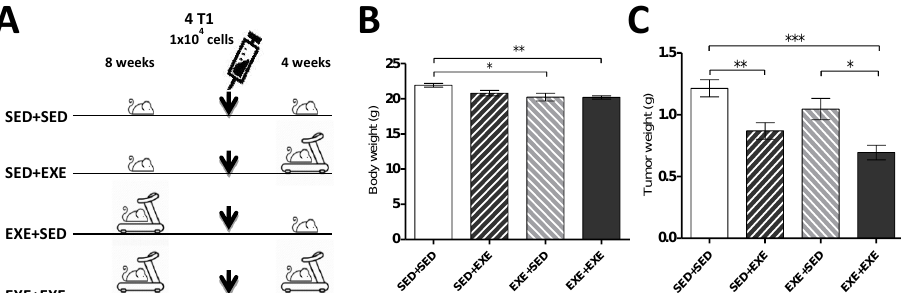
Figure 1. Physical exercises reduce body weight and tumor mass in the triple-negative breast cancer (TNBC) experimental model (4T1 cells). ( A ) Experimental design. ( B ) Body weight. ( C ) Tumor weight. One-way ANOVA with Bonferroni post hoc test. SED + SED n = 9; SED + EXE n = 8; EXE + SED n = 6; EXE + EXE n = 8. Means ± SEM. * p < 0.05; ** p < 0.01; *** p < 0.001.